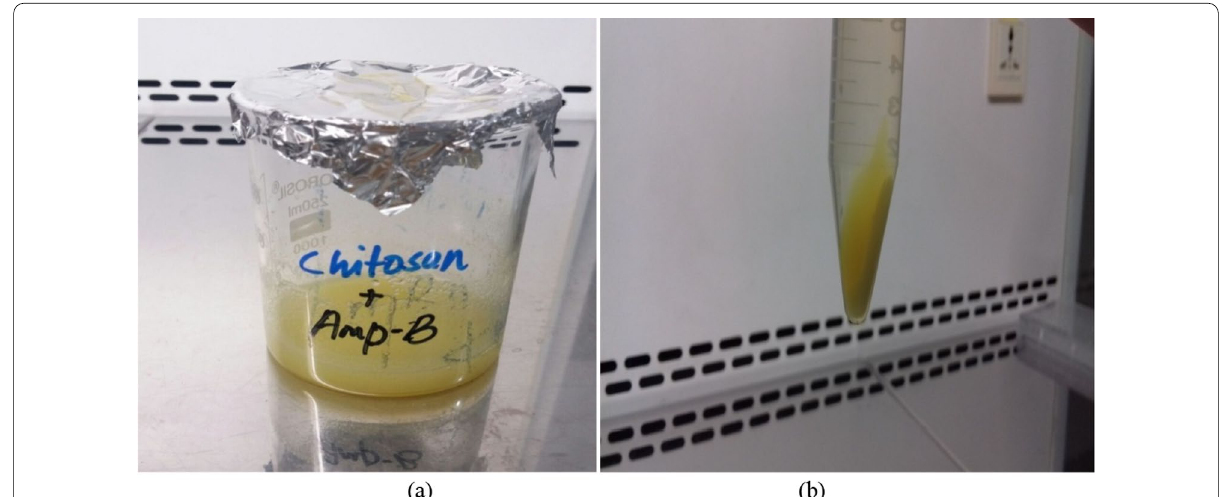
Fig. 1 a AmB-CNPs in solution form, b AmB-CNPs in pellet